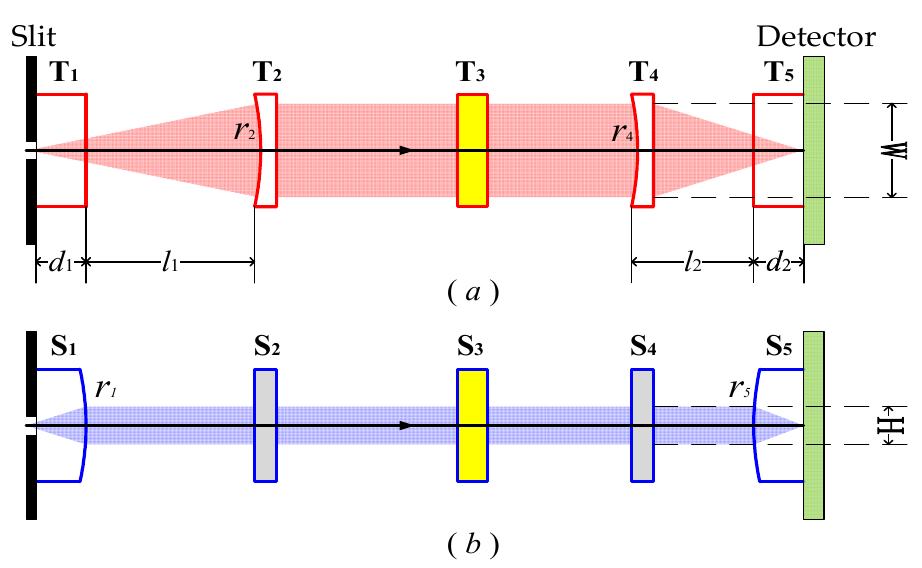
Figure 2. The theoretical schematic diagram: ( a ) UTCT in tangential plane ( b ) UTCT in sagittal plane. According to Coddington’s equations, the relation of OD and ID in tangential plane and sagittal plane can be expressed as